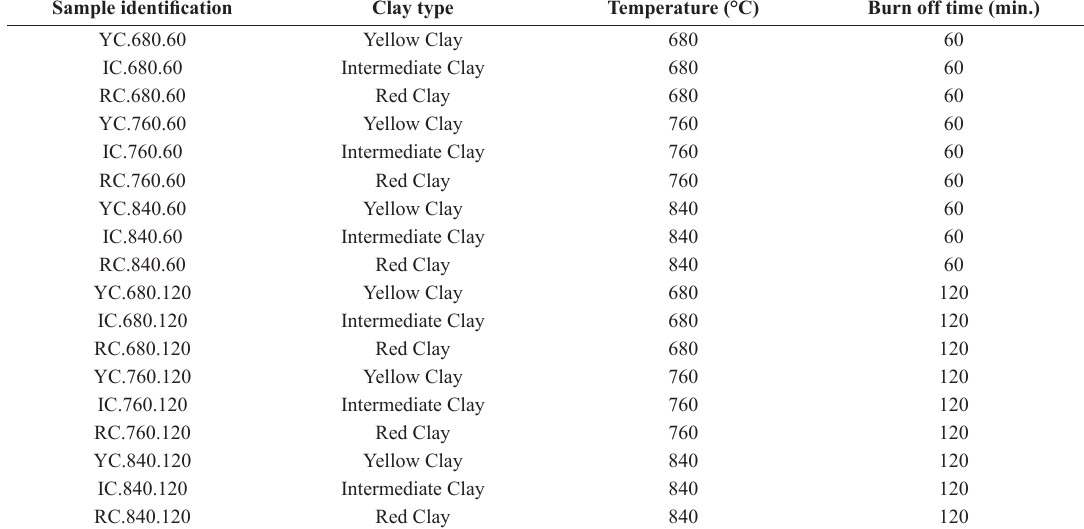
Table 2. Calcination